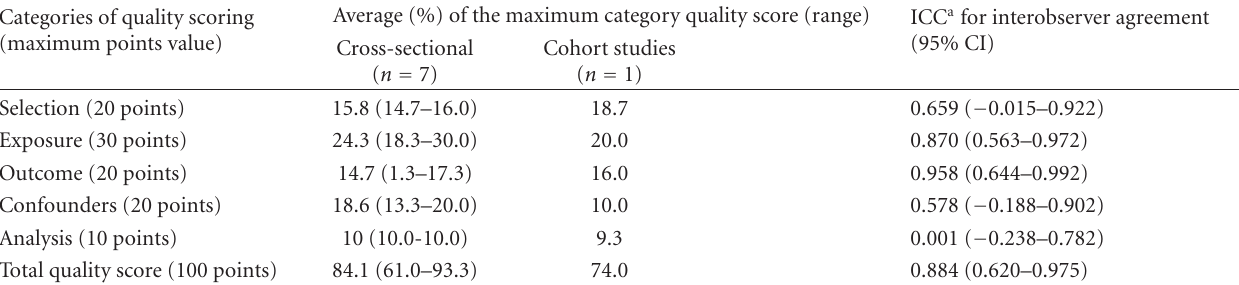
Table 2: Average quality scores on quality scores for studies included in the meta-analysis.